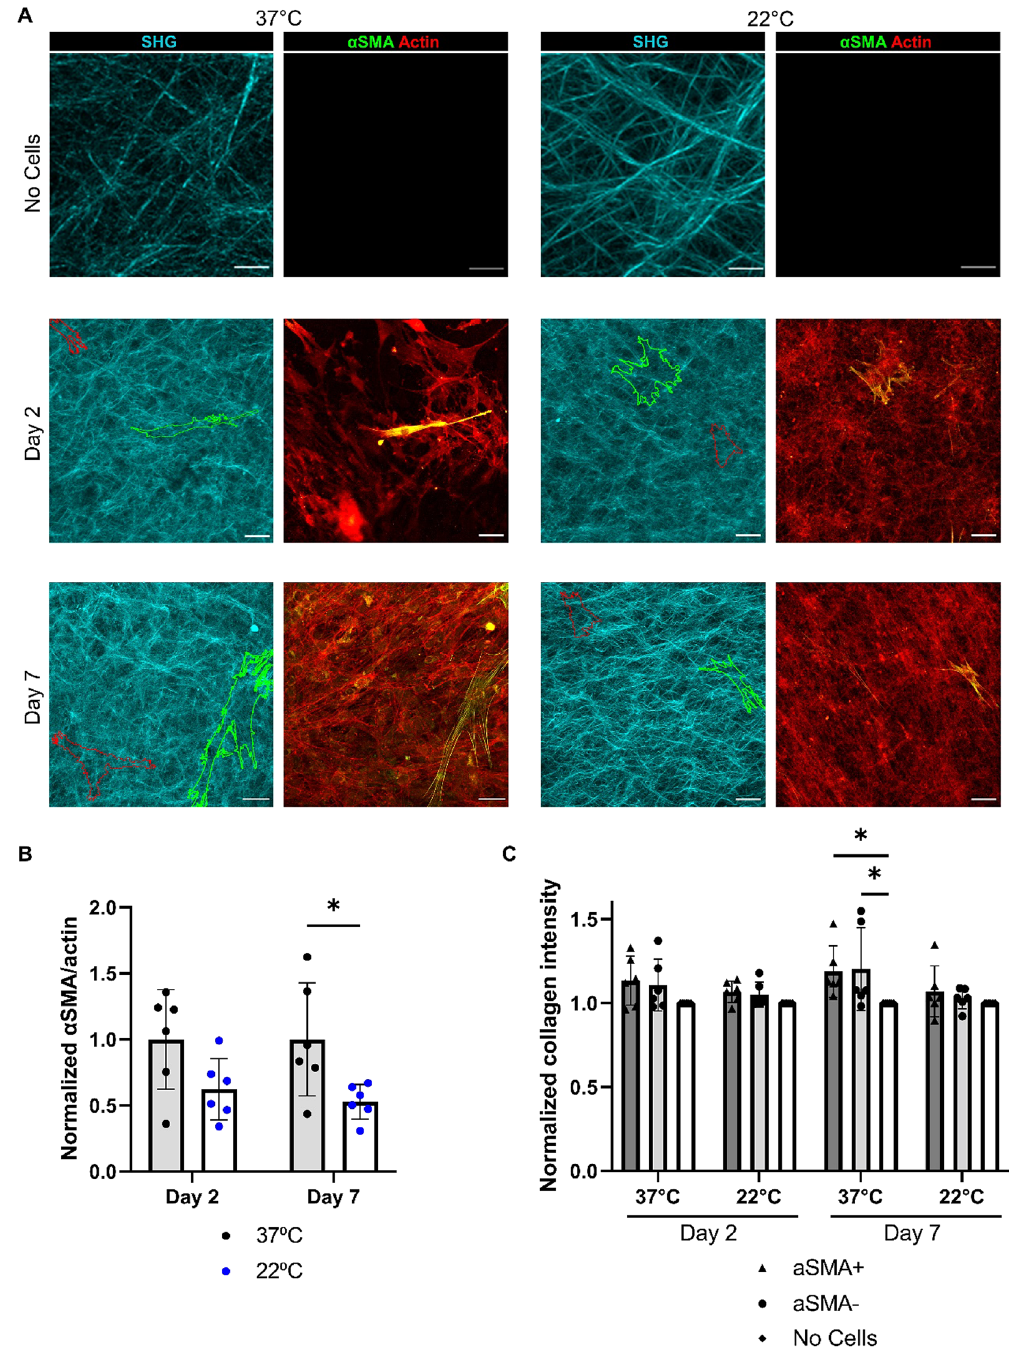
Figure 6. SHG imaging of 3 mg/ml collagen gels polymerized at different temperatures. ( A ) SHG images of collagen gels polymerized at 37 °C and 22 °C at day 2 and day 7 after cell seeding. Scale bars on no cell images set to 10 μm. Scales bars on day 2 and day 7 images set to 50 μm. Red outlines indicate a αSMA− FAP and green outlines indicate a αSMA+ FAP. ( B ) Myofibroblast activation at day 2 and day 7 across the gels. ( C ) Collagen intensity under no cells, αSMA+, or αSMA− FAPs. Intensity normalized to areas of gels without cells. * P < 0.05 using a two-way ANOVA with multiple comparisons using Tukey correction. N = 2 independent gels and n = 3 fields per